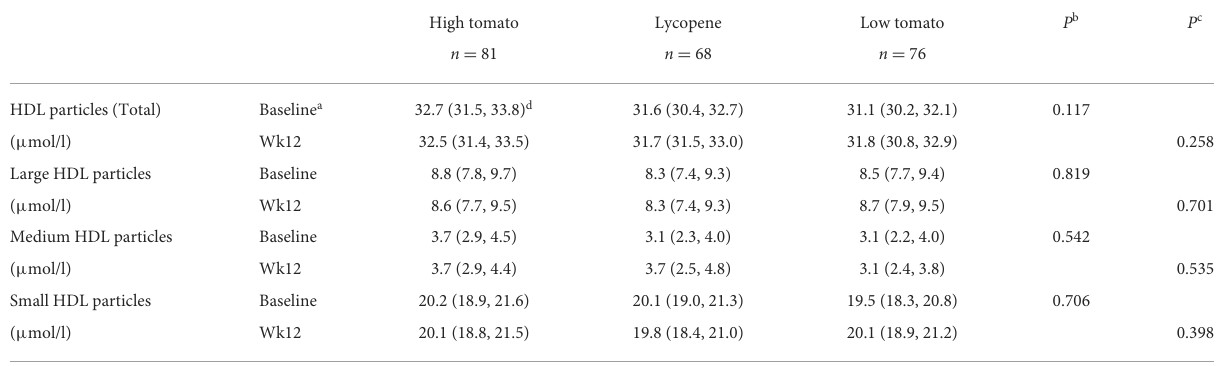
TABLE 8 HDL subclass distribution in response to 12-week intervention with high tomato, lycopene, and control diets.